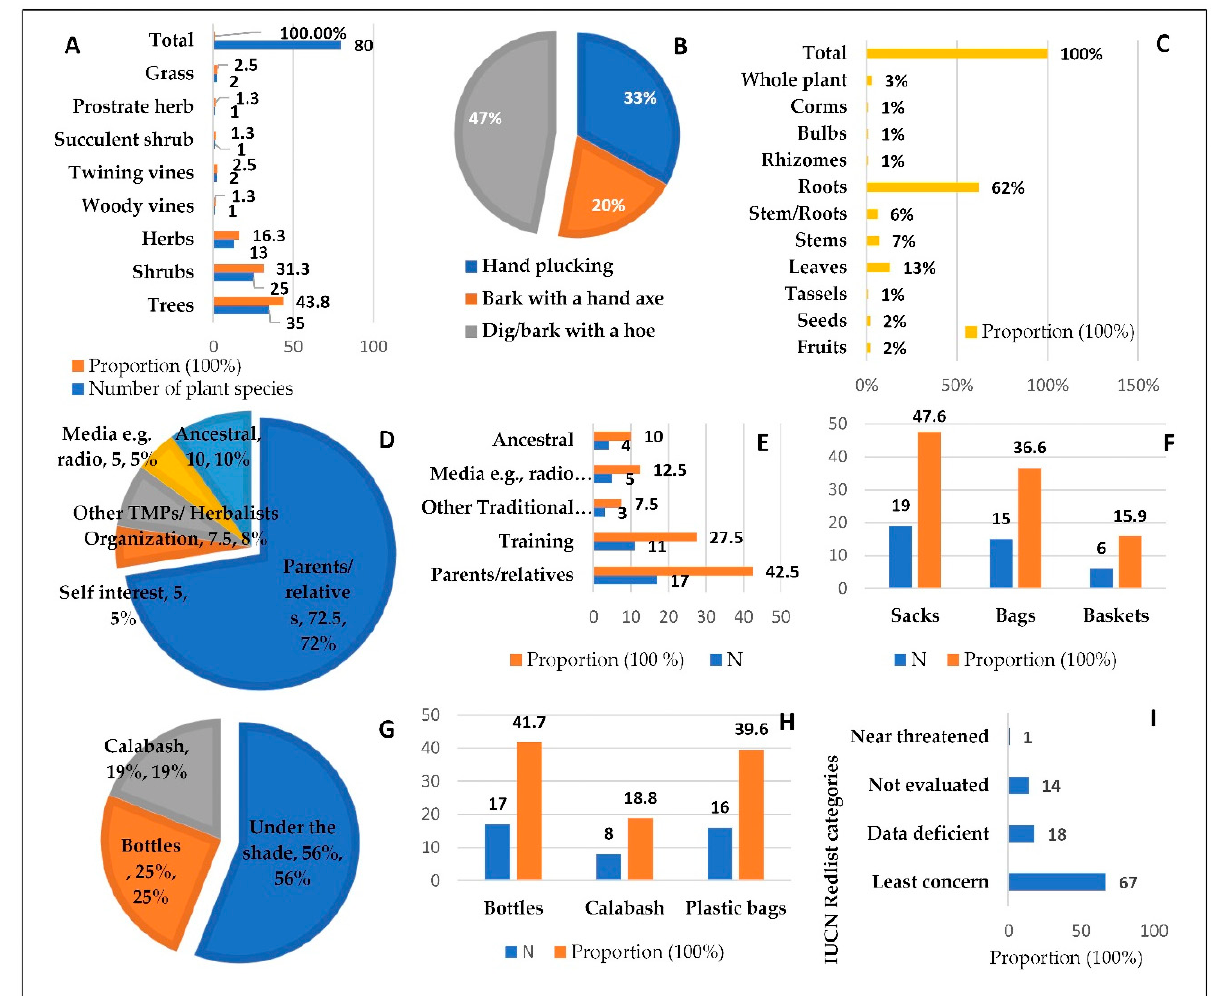
Figure 3. ( A ) Plant habits of the 80 documented medicinal plants; ( B ) methods of collecting/harvesting plant material; ( C ) medicinal plant parts used by participants in this study; ( D ) sources of TK on phytomedicines’ use; ( E ) sources of TK on harvesting/collection of medicinal plants; ( F ) modes of collecting/harvesting medicinal plants; ( G ) modes of storage of unprocessed medicinal plants; ( H ) modes of storage of processed medicinal plants; ( I ) IUCN Red List categories of the documented plants.